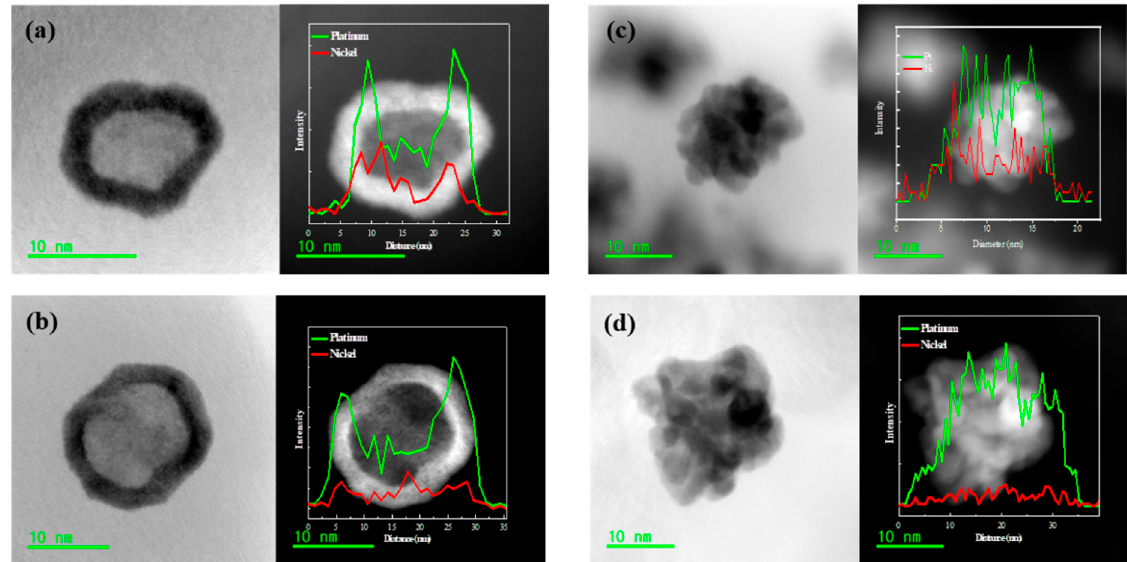
Figure 1. High-resolution (HR)-TEM images and line-scan profiles of ( a ) PtNi 3 /C–H, ( b ) PtNi 3 /C–H AT, ( c ) PtNi 3 /C–S, and ( d ) PtNi 3 /C–S AT.